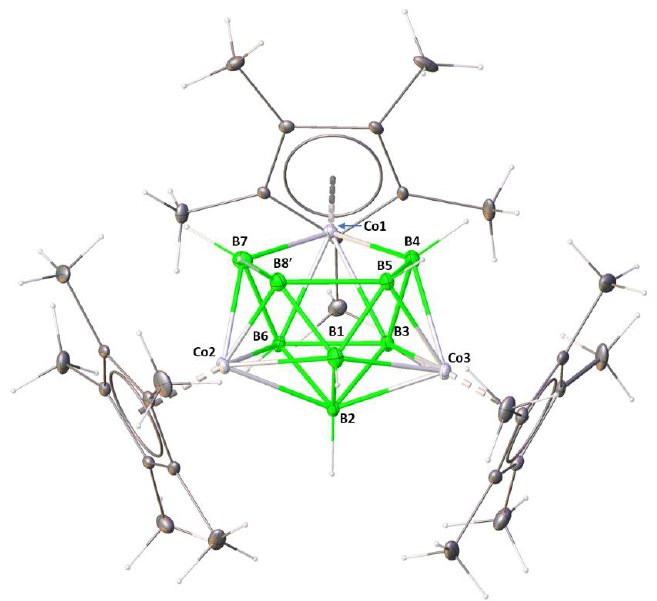
Figure 1. Molecular structure and atom labels of one of the residues of 1 . Selected bond lengths (Å )